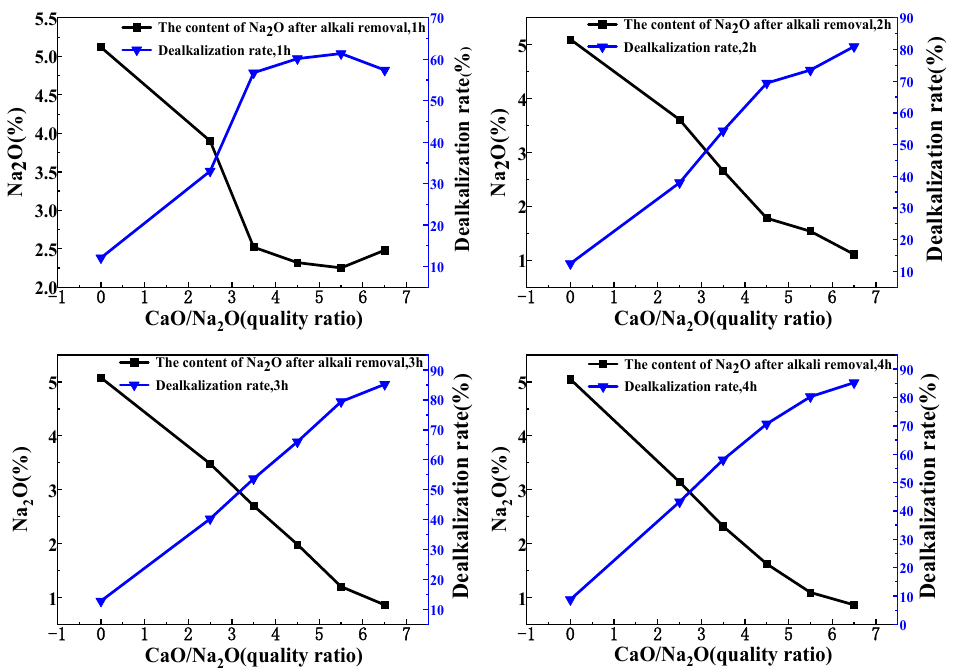
Figure 12. Effect of CaO on dealkalization rate.